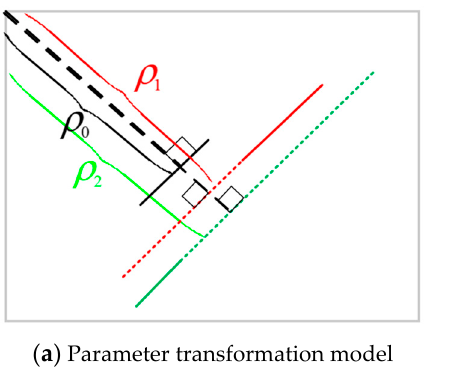
Figure 5. Local road line set optimization.